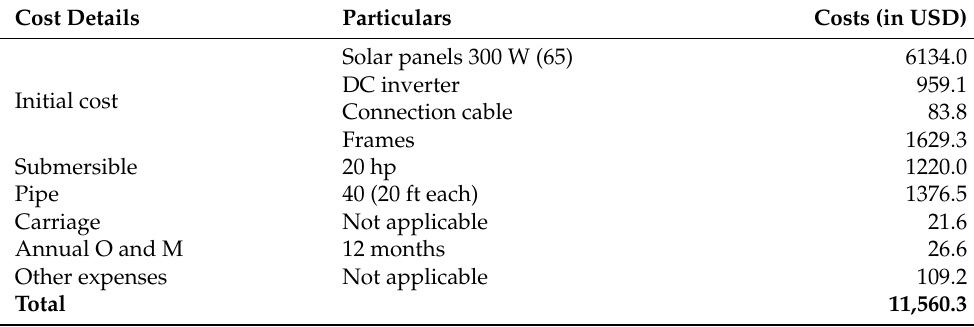
Table 2. Costs related to PV solar